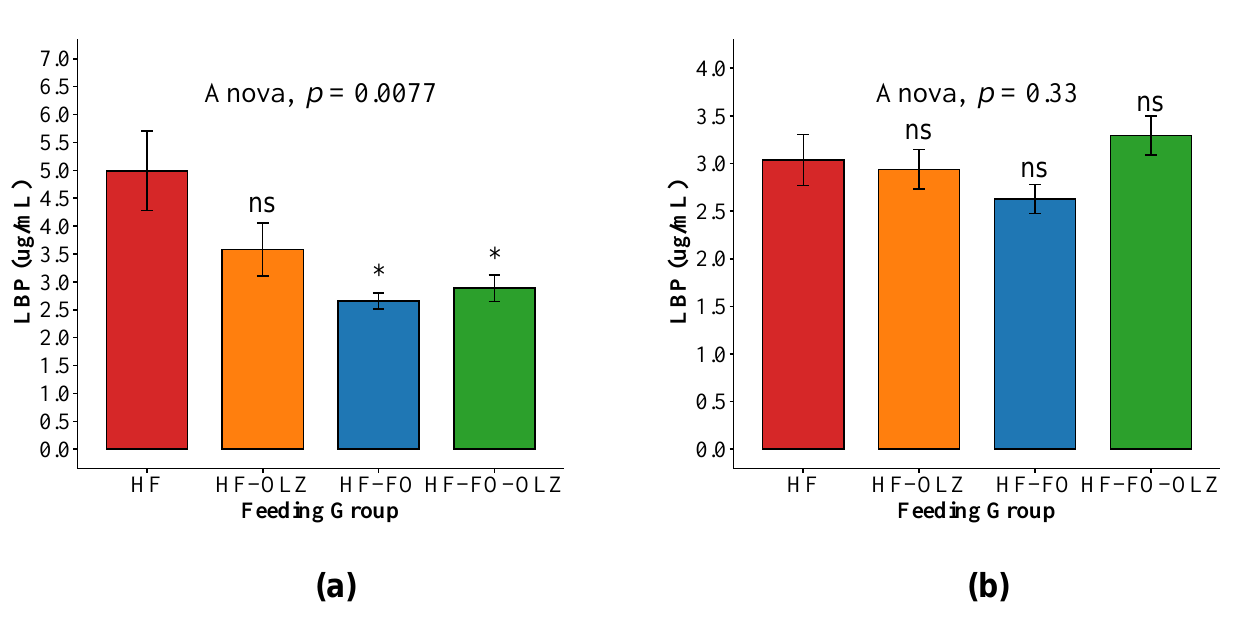
Figure 2. Serum lipopolysaccharide binding protein (LBP) levels in male ( a ) and female ( b ) mice. Data are shown as mean ± SEM for each group. ANOVA p -value for the multiple group comparisons are shown. The pairwise comparison is to compare the HF group versus the other groups, individually (* for p -value < 0.05, ns for p -value ≥